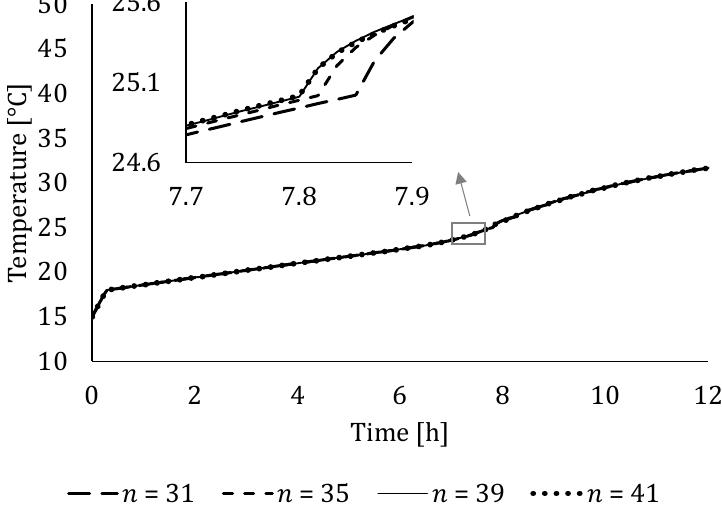
Figure 5. Transient PCM temperature variations at the middle axial position of LTES during melting for HTF flow rate 620 l/h and HTF inlet temperature 37 °C, obtained by computational model with different number of LTES tank isothermal segments.